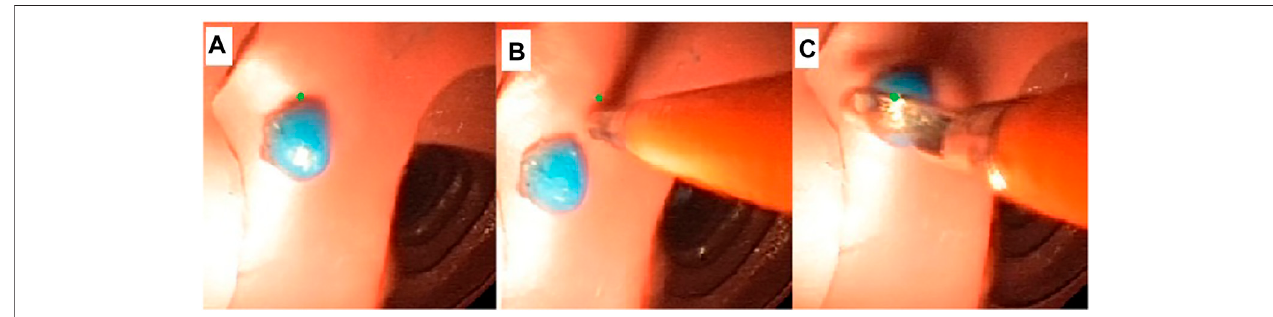
FIGURE6| Targetedbiopsyroutine. (A) Thepolypisdetected bytheuser.Thegreendotisanestimated projectionofthebiopsytool givenanaveragedistanceof theendoscopefromthetarget(Martinetal.,2021). (B) Theinsertionofthebiopsyforcepsthroughtheworkingchannelleadstoadeviationofthetipoftheendoscopeto